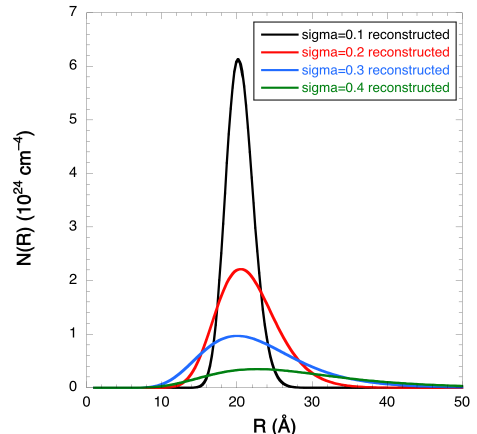
Figure 5. SDFs reconstructed with the parameters ( N o , R o and σ ) calculated with the SPA for the four cases ( σ = 0.1, 0.2, 0.3 and 0.4). The original SDFs are shown in Figure